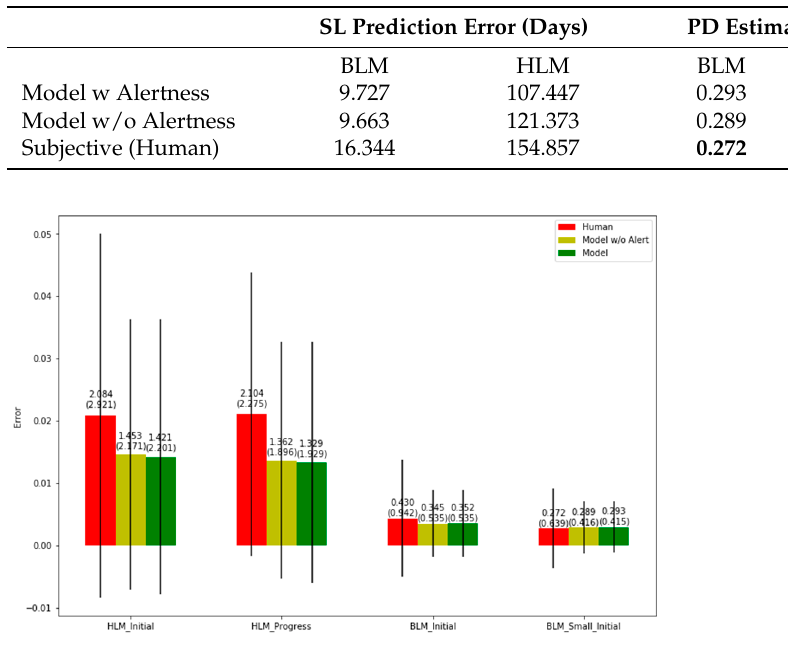
Figure 7. Error metrics of all industries (N = 2932). Table 3. Results comparison.